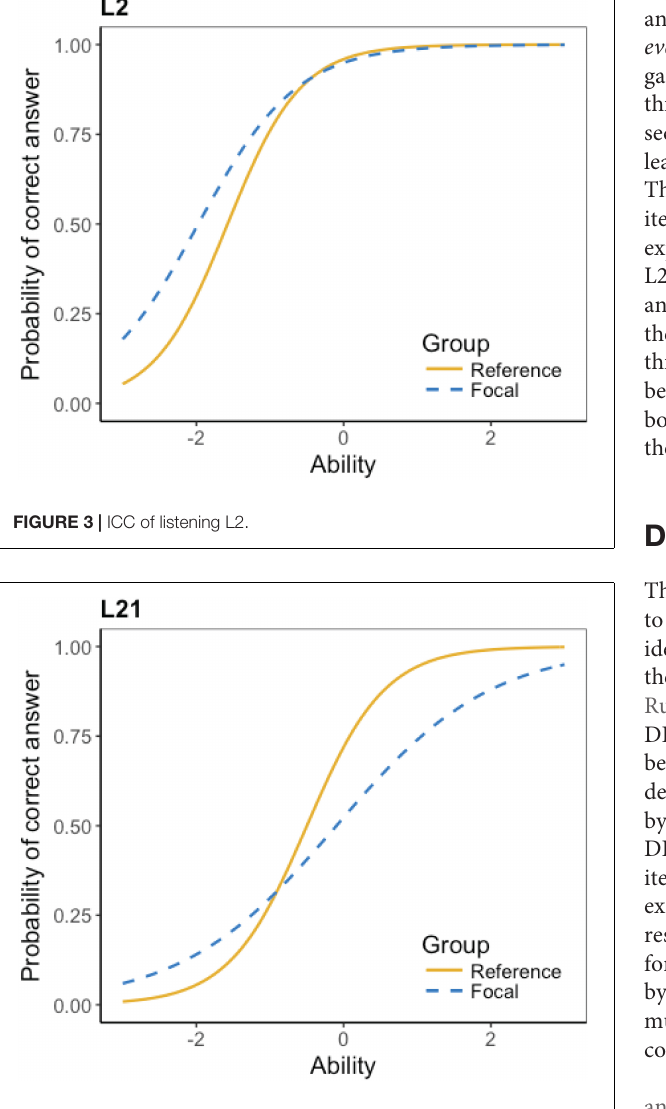
FIGURE 4 | ICC of listening